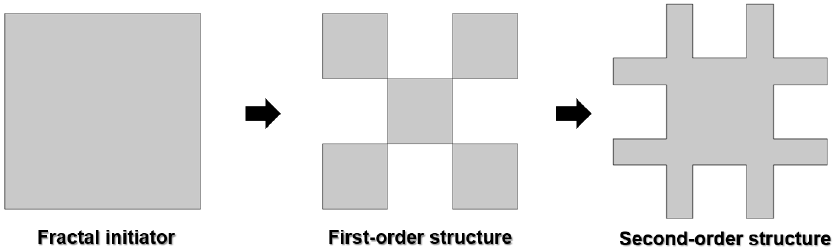
Figure 4. Iterative generation of the second-order Minkowski fractal geometry.